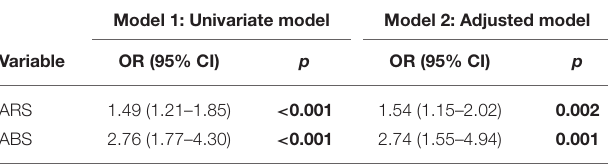
TABLE 3 | Odds ratios for postoperative delirium according to ARS and ABS. Model 1: Univariate